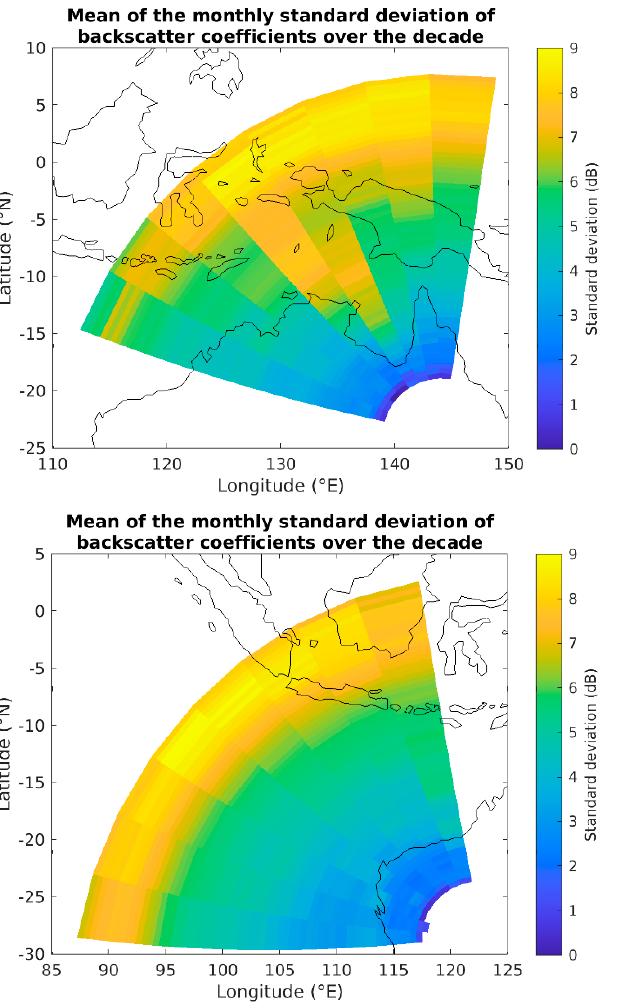
Figure 7. Decade mean of the monthly mean backscatter coefficients for LO ( top left ), LAE ( top right ), LAW ( bottom left ) and AS ( bottom right ).